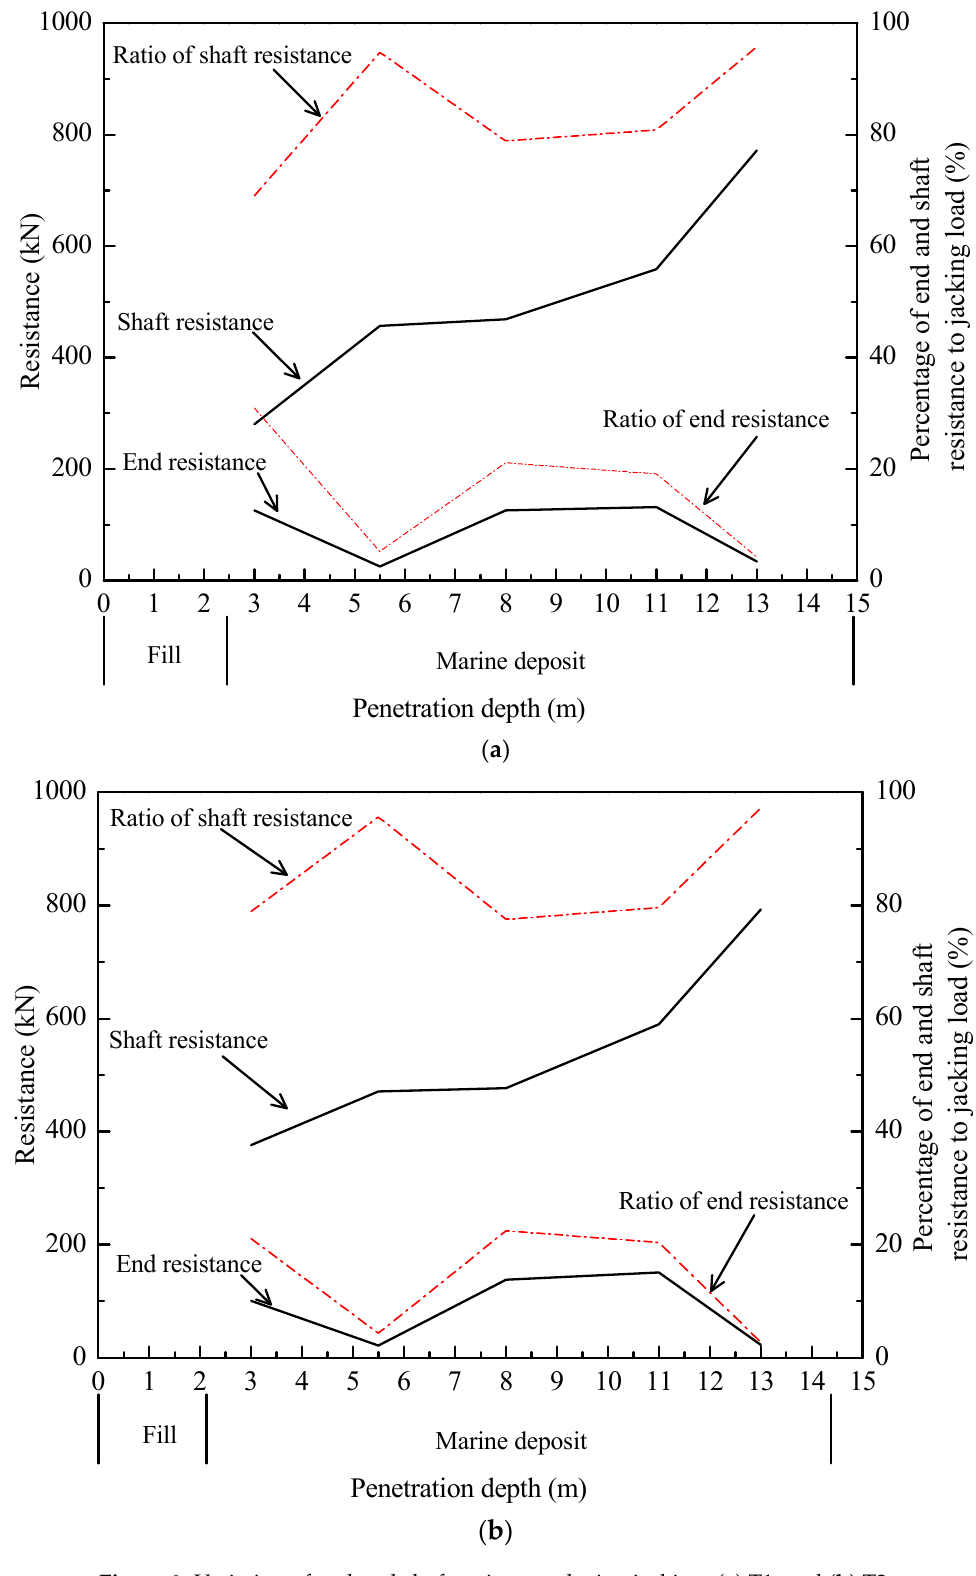
Figure 9. Variation of end and shaft resistance during jacking: ( a ) T1; and ( b ) T2.